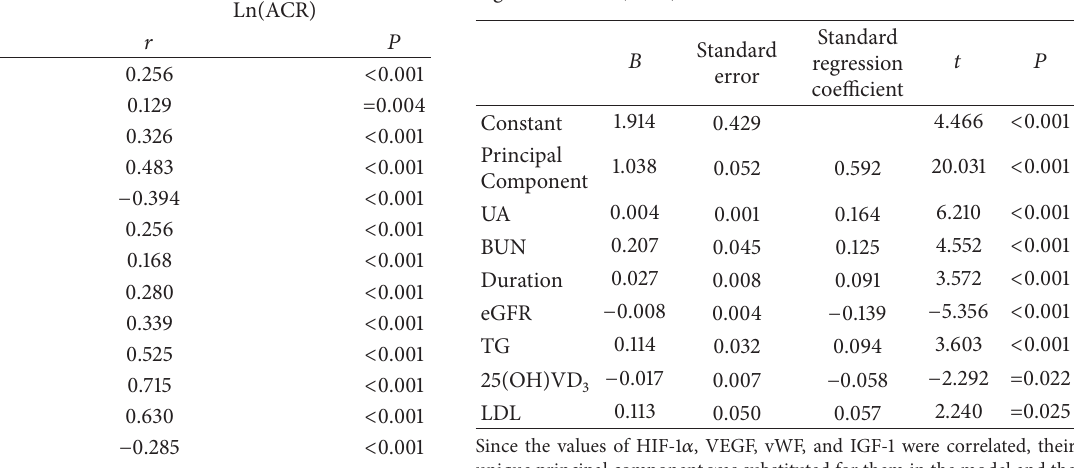
Table 3: Multiple stepwise regression and principal component regression of Ln(ACR) and related